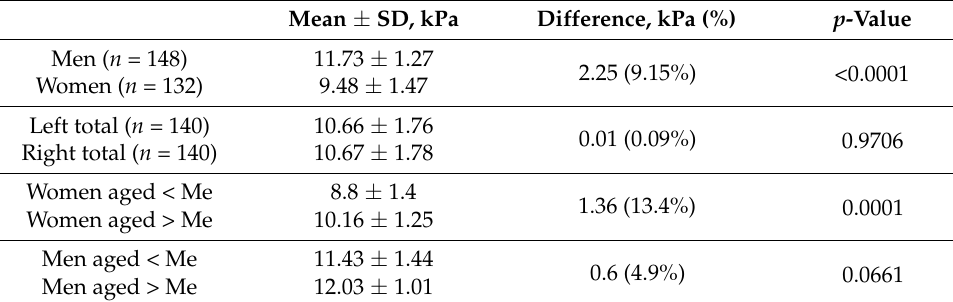
Figure 2. Age distribution in the study group by gender with a stiffness means expressed in kPa for age range. Table 1. Values of stiffness in the study group.